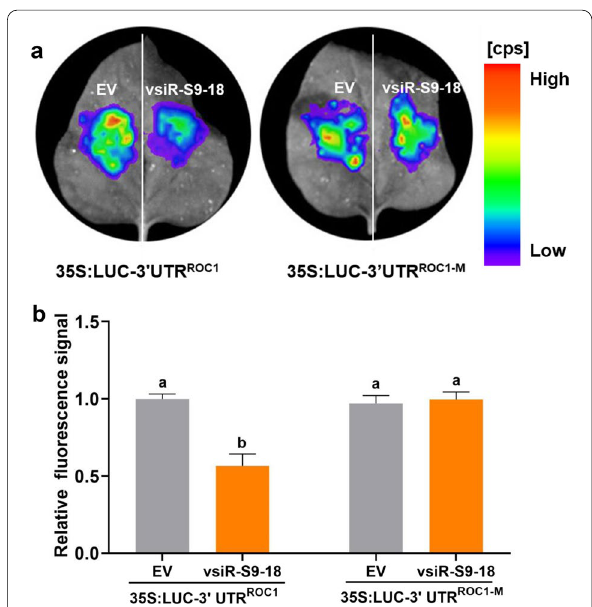
Fig. 2 vsiR-S9-18 specifically mediates mRNA degradation of ROC1 in tobacco cells. a Luciferase complementation imaging assay for the degradation of ROC1 in N. benthamiana leaves. Agrobacterium strain C58C1 harboring various combinations of the constructs was infiltrated into N. benthamiana leaves. At 72 h post-infiltration, luciferase activities were determined. Cps, signal counts per second. b Relative fluorescence signal of the samples in a . Values represent the